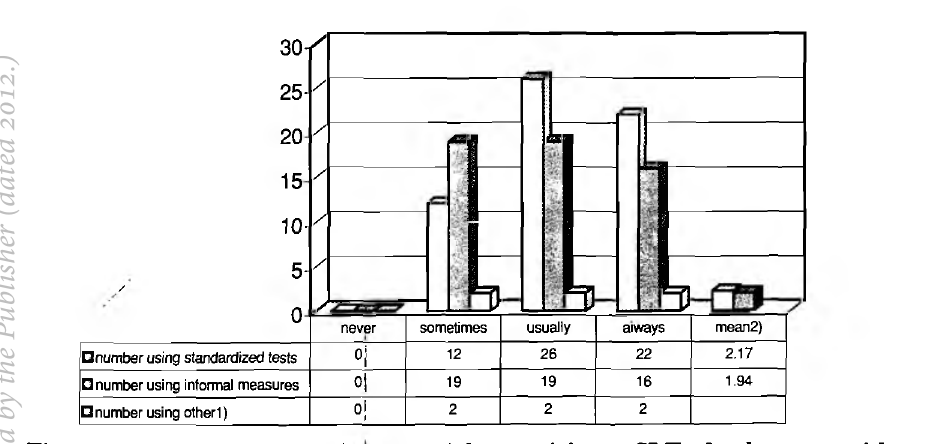
Figure 3: Assessment procedures used by participant SLTs for learners with LLD and WFDs (n=60)